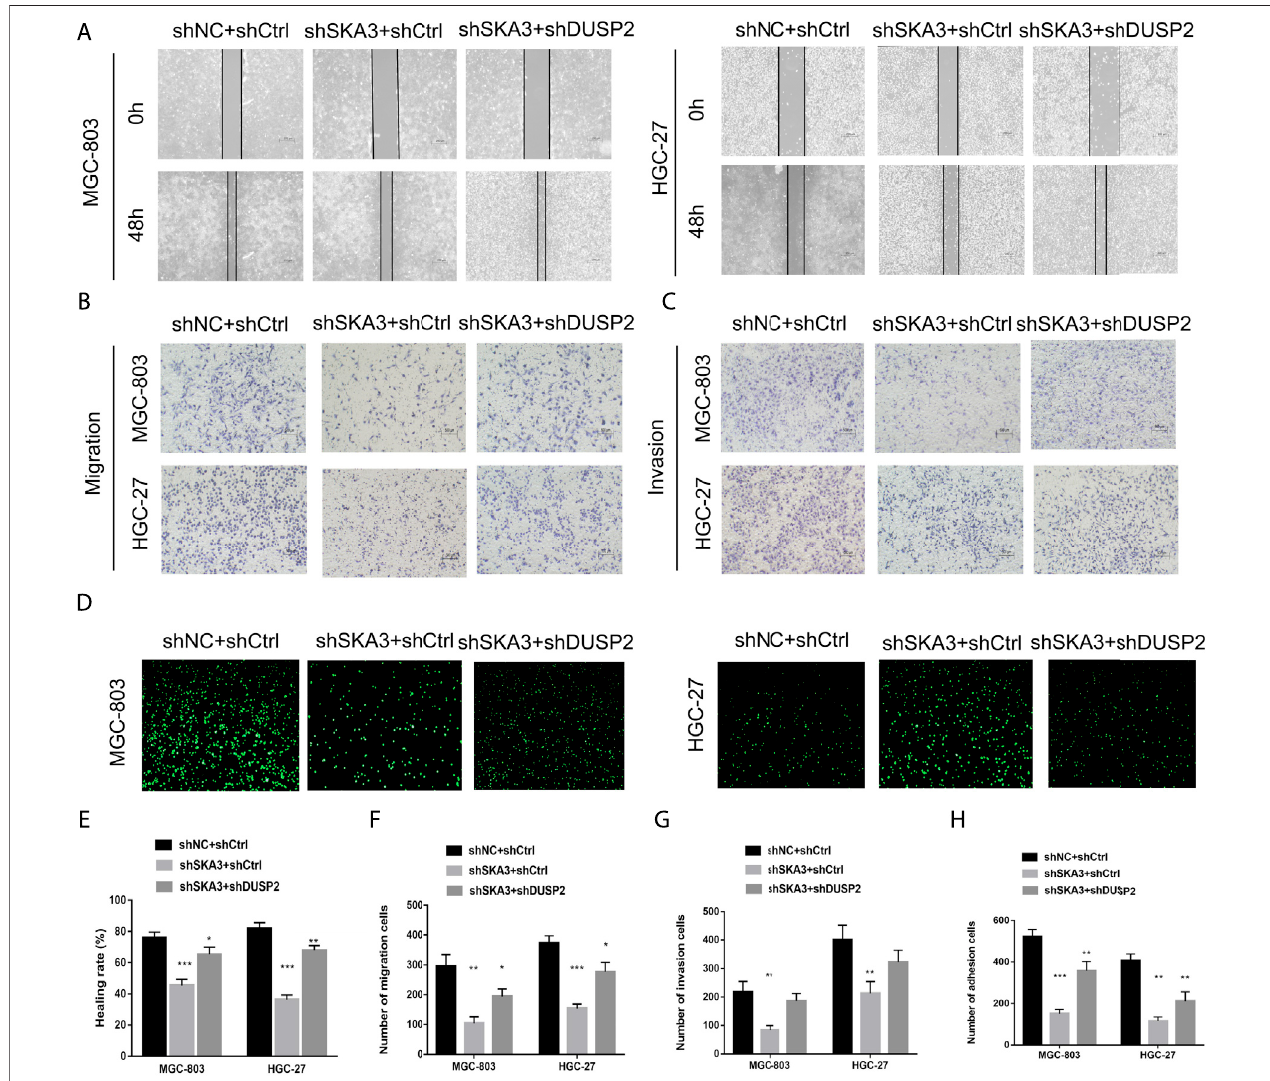
FIGURE 7 | SKA3 mediates DUSP2 induced migration, invasion and adhesion by inactivating MAPK/ERK pathway. (A) The inhibiting effect of SKA3 downregulation on MGC-803 and HGC-27 wound-healing was rescued by shDUSP2 transfection. (B) The inhibiting effect of SKA3 downregulation on MGC-803 and HGC-27 migration was rescued by shDUSP2 transfection. (C) The inhibiting effect of SKA3 downregulation on MGC-803 and HGC-27 invasion was rescued by shDUSP2 transfection. (D) The inhibiting effect of SKA3 downregulation on MGC-803 and HGC-27 adhesion was rescued by shDUSP2 transfection. (E) Relative healingratein (A) werequanti fi ed andshown. (F) Relativemigrationnumbers in (B) werequanti fi ed andshown. (G) Relative invasionnumbersin (C) werequanti fi edand shown. (H) Relative adhesion numbers in (D) were quanti fi ed and shown. Data are shown as mean ± SD for triplicate experiments. The two-tailed Student ’ s unpaired t -test was used. * p < 0.05, ** p < 0.01, *** p <